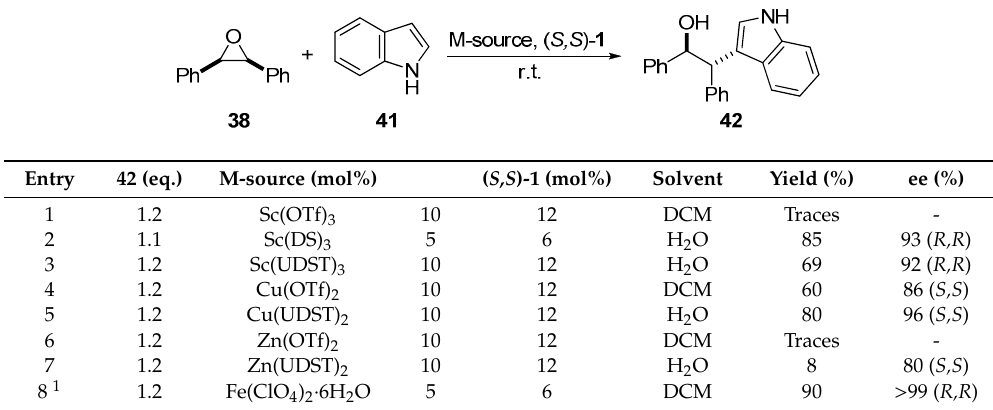
Table 8. Opening of epoxide ring by indole.